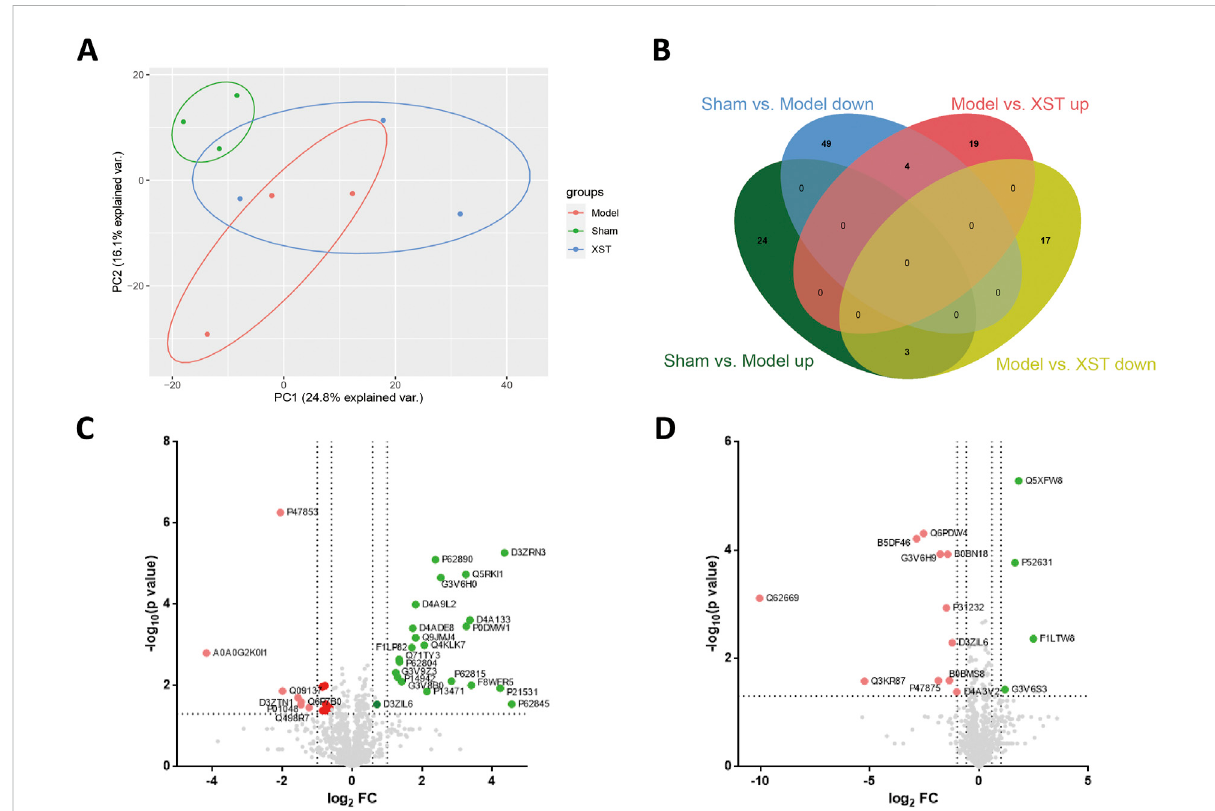
FIGURE 5 Differentially expressed proteins (DEPs) detected by label-free proteomics analysis in the left ventricle between Sham: model and Model: XST. (A) Principal component analysis (PCA) of all detected proteins of the three groups: the sham group, model group, and XST group. (B) Venn diagram showing the overlap of all DEPs. (C) Volcano plot of DEPs of Sham: model. (D) Volcano plot of DEPs of Model: XST. Red dots represent upregulated DEPs, green dots represent downregulated DEPs, and gray dots represent unchanged